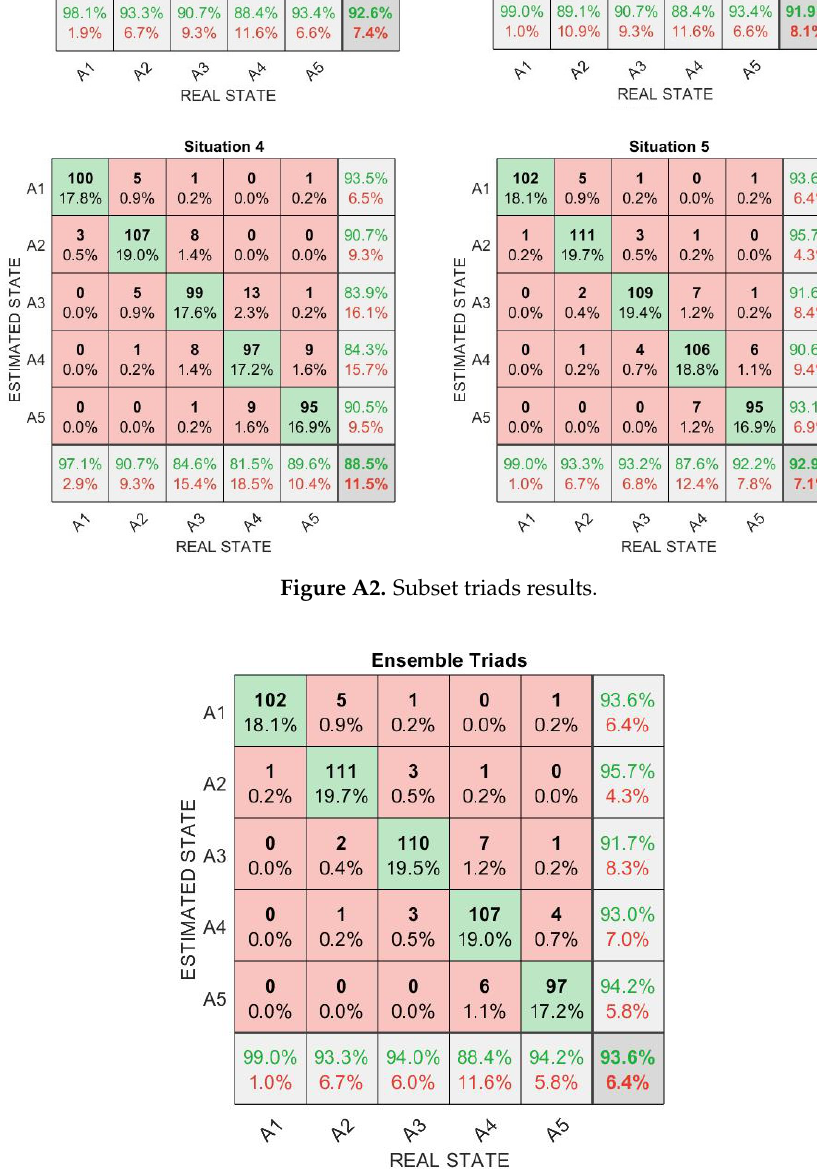
Figure A3. Confusion matrix Ensemble